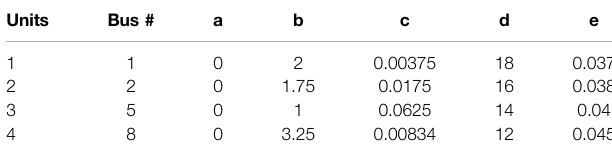
TABLE 3 | Cost coef fi cients of single-fuel generators (Biswas et al.,